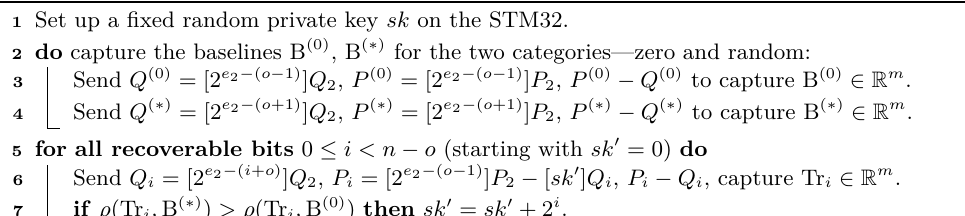
Algorithm 5: Experimental attack on isogeny computation (cf. Algorithms 2,4).